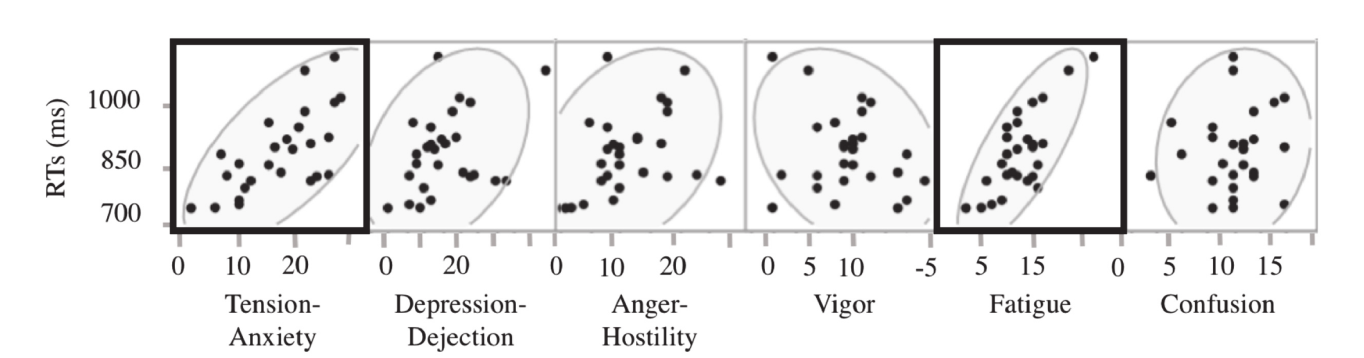
Fig 2. Analysis of the association between RTs and POMS scores. The horizontal axis shows POMS subscale scores and the vertical axis indicates RTs; scores for the 27 subjects are represented by dots in the gray regions. Bold boxes indicate significant correlations. There were significant positive correlations between RTs and scores for the Tension-Anxiety ( r = 0.679, p < 0.01) and Fatigue ( r = 0.585, p < 0.01) subscales. Correlation coefficients ( r ) were analyzed via Spearman’s rank-order correlation analysis. n = 27, (cid:3) p < .05.